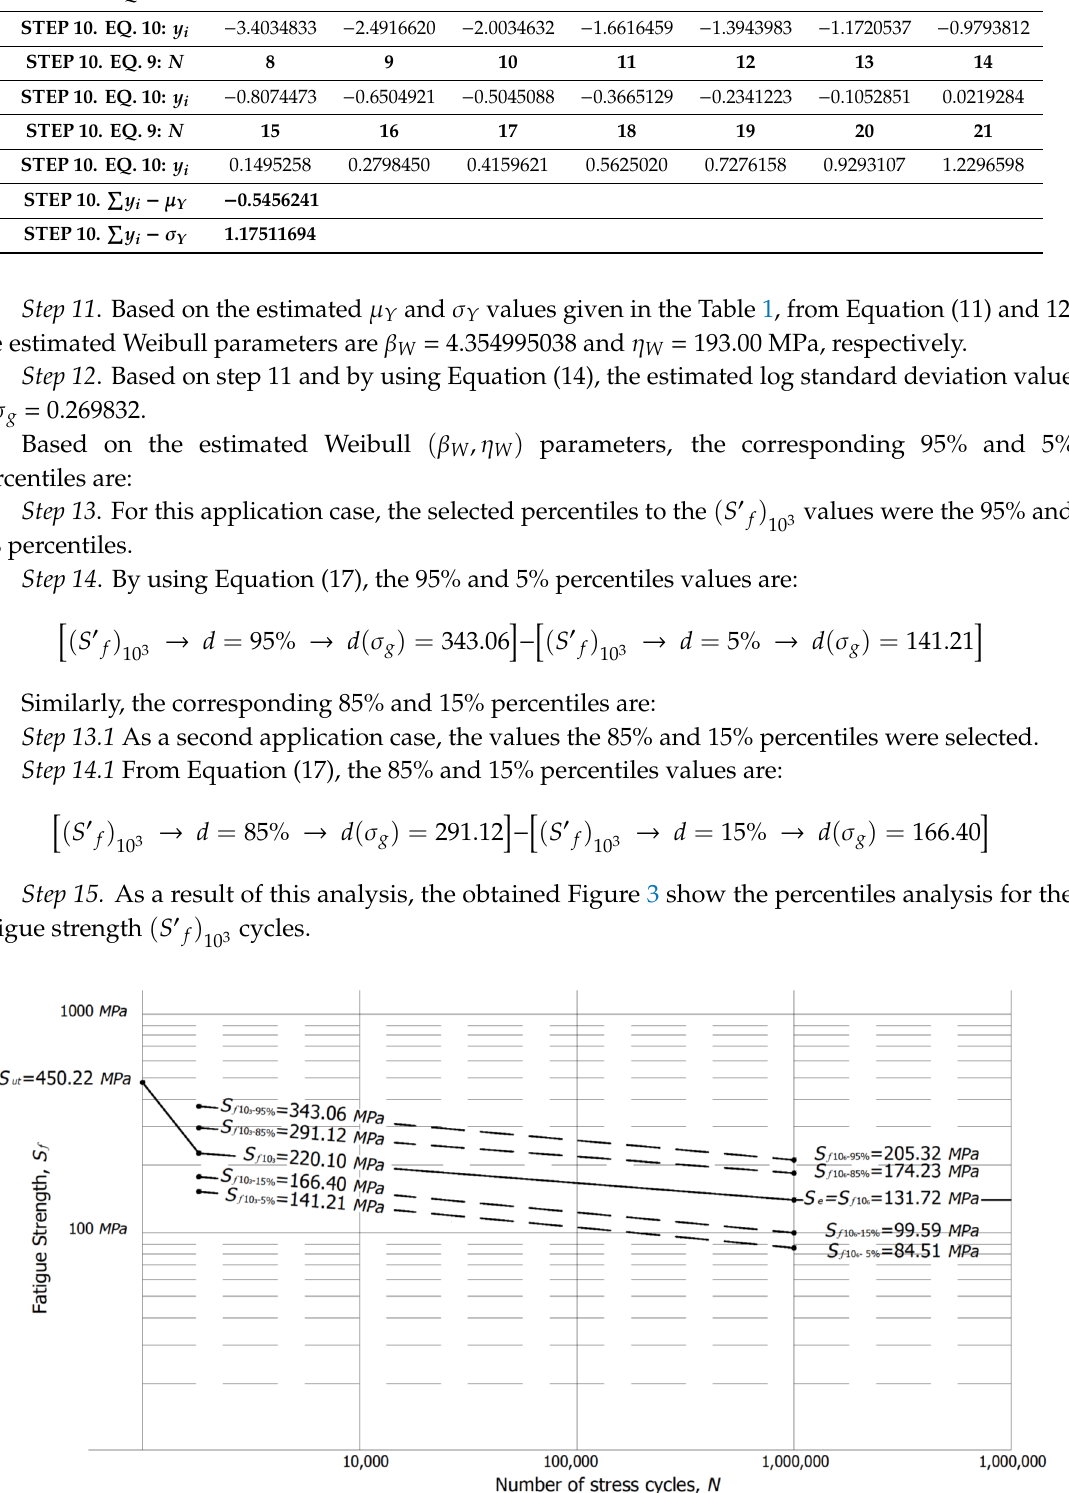
Table 1. Mean (cid:2020) (cid:3026) and standard deviation (cid:2026) (cid:3026) .